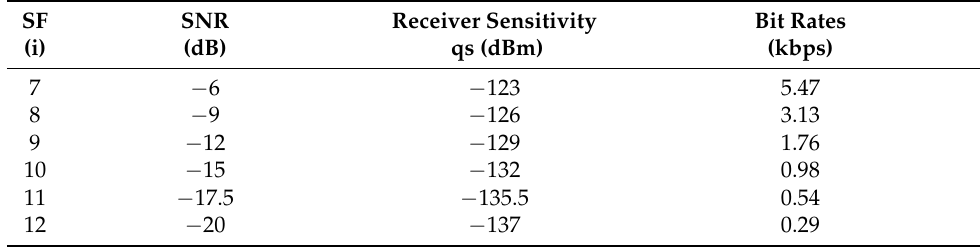
Table 1. LoRa parameters based on